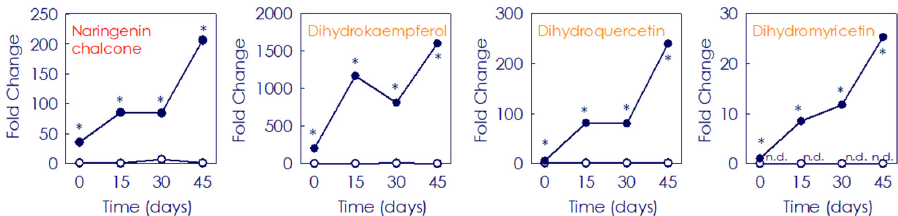
Figure 4. Fold change of naringenin chalcone (flavonoids precursor, in red colour) and the dihydro- flavonoids (anthocyanins precursors, in orange colour) dihydrokampherol, dihydroquecetin and dihydromyricetin in the pulp of Moro ( ● ) and Pera ( ○ ) oranges during storage for 0, 15, 30 and 45 days. Data are expressed as the mean fold change ± SD of each sample compared to the control Pera fruits sample (at harvest time). Asterisk indicates statistically significant different values ( p ≤ 0.01) for each given time.